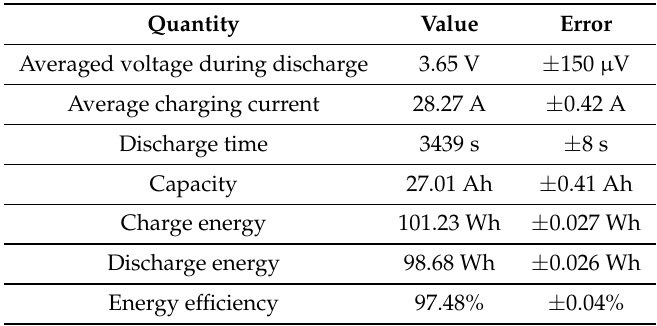
Table 3. Experimental setup measurement